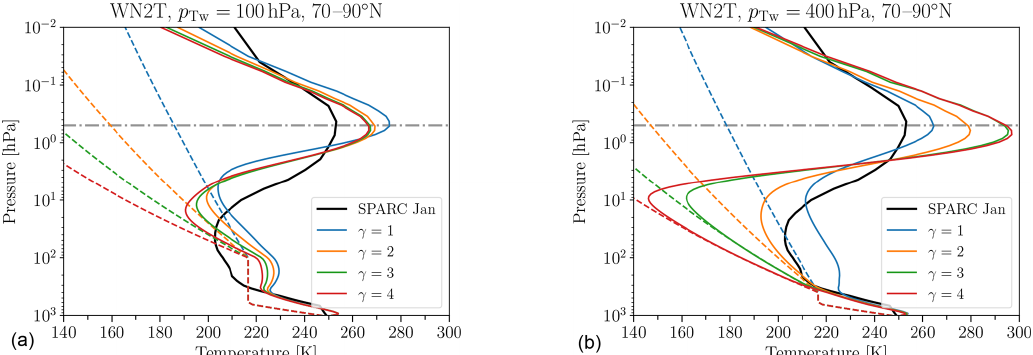
Figure 9. Polar winter temperature profiles of model simulations with WN2 topography of height h = 3km and different polar vortex lapse rates γ for p Tw = 100hPa (a) and p Tw = 400hPa (b) , together with the temperature profiles obtained from the SPARC climatology (black line) as well as the equilibrium temperature profiles (dashed colored lines). Averages are based on about